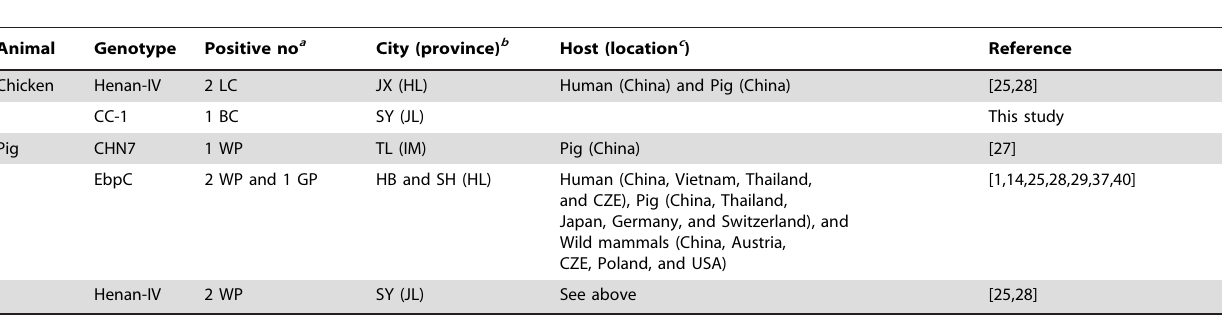
Table 1. Enterocytozoon bieneusi genotypes identified in farmed chickens and pigs in China.